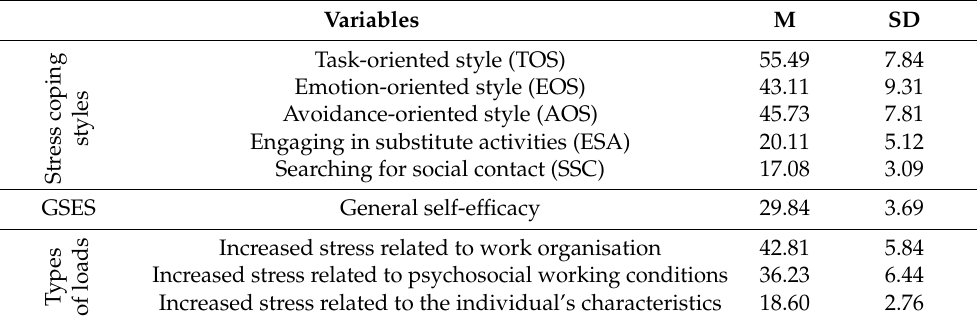
Table 2. Mean scores of nurses’ stress-coping styles and their organisational, individual and psy- chosocial working